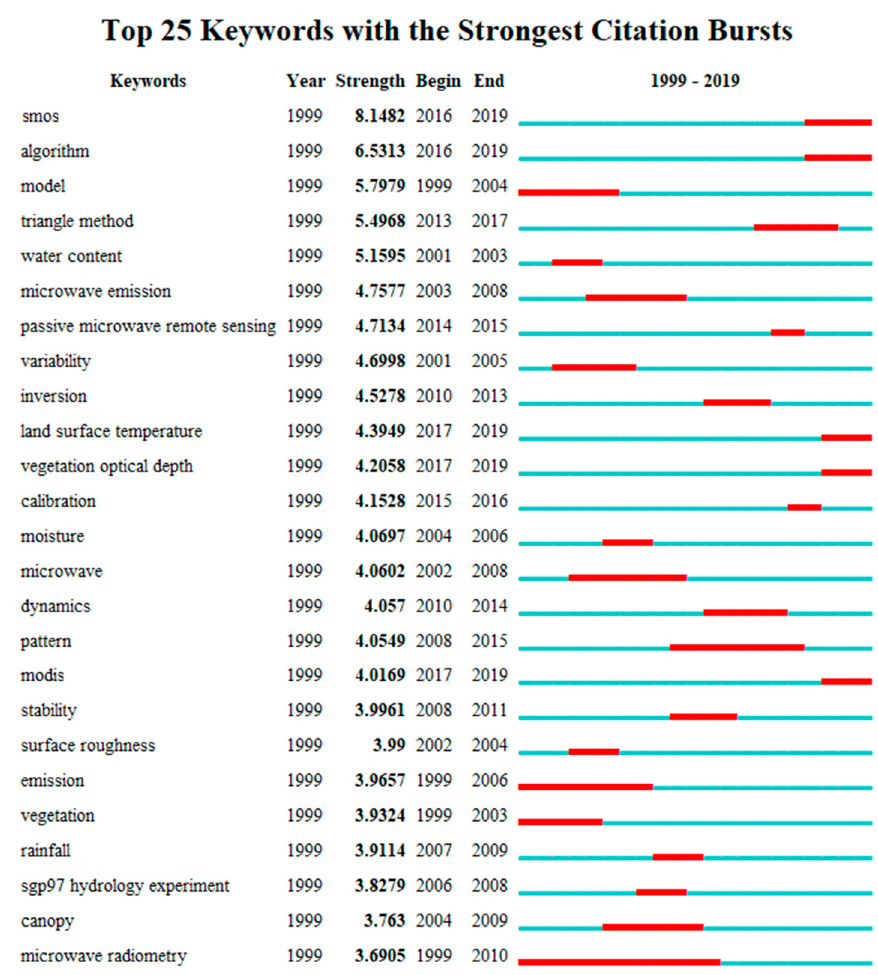
Figure 2. Analysis of emergent